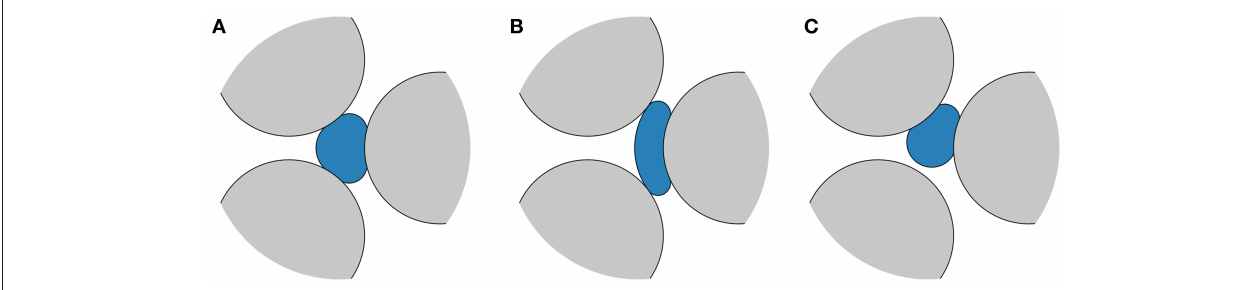
FIGURE 3 | (A) Small non-wetting bubble (blue) whose volume is small compared to the link volumes and is prevented from splitting by interfacial tension. This limits the minimum size of non-wetting bubbles, which will either (B) be stuck or (C) move through one of the links without splitting.